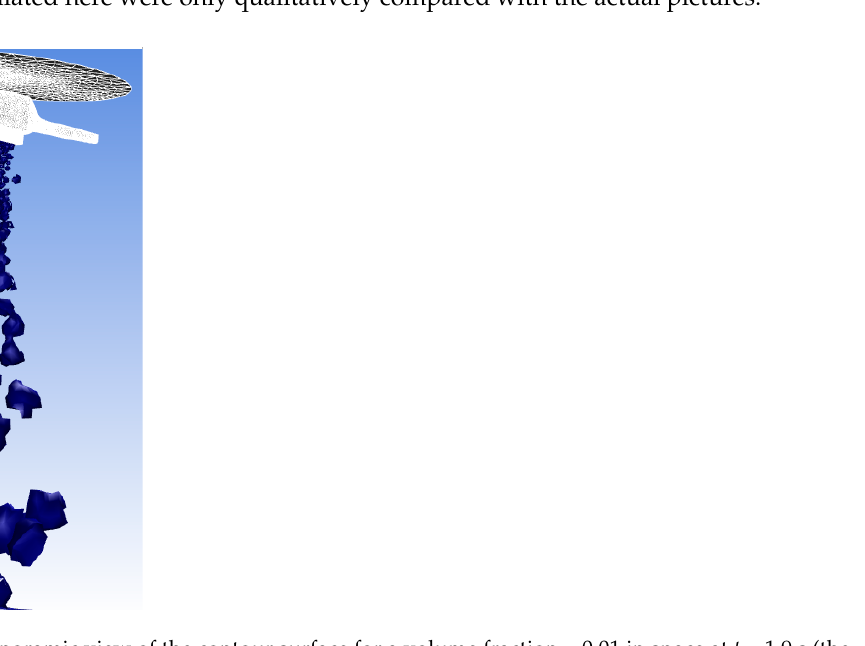
Figure 16. Panoramic view of the contour surface for a volume fraction = 0.01 in space at t = 1.9 s